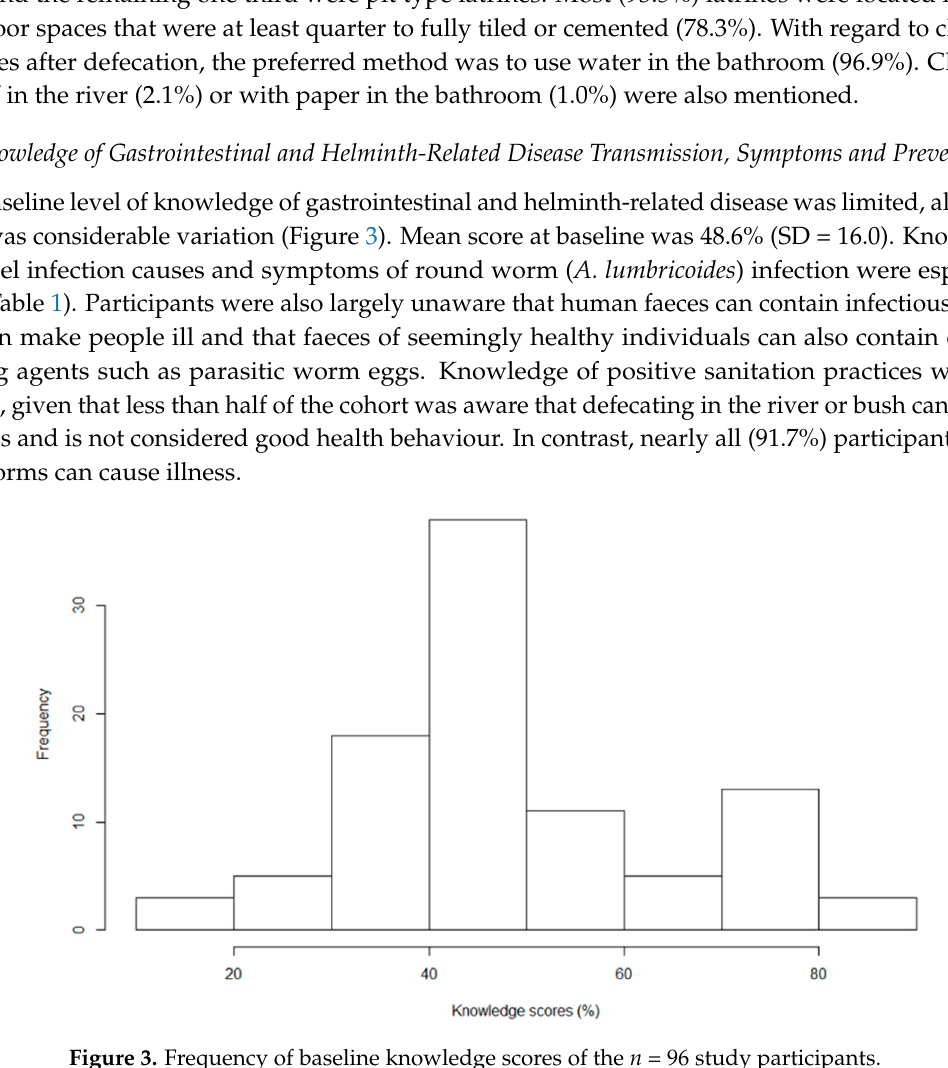
Figure 3. Frequency of baseline knowledge scores of the n = 96 study participants.